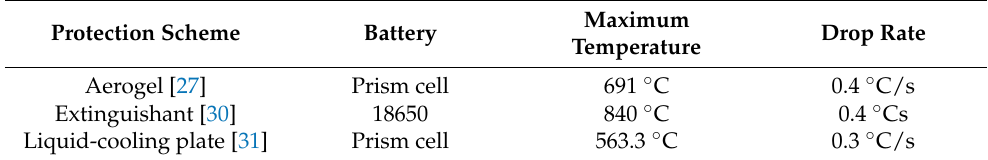
Table 1. Commonly used protection